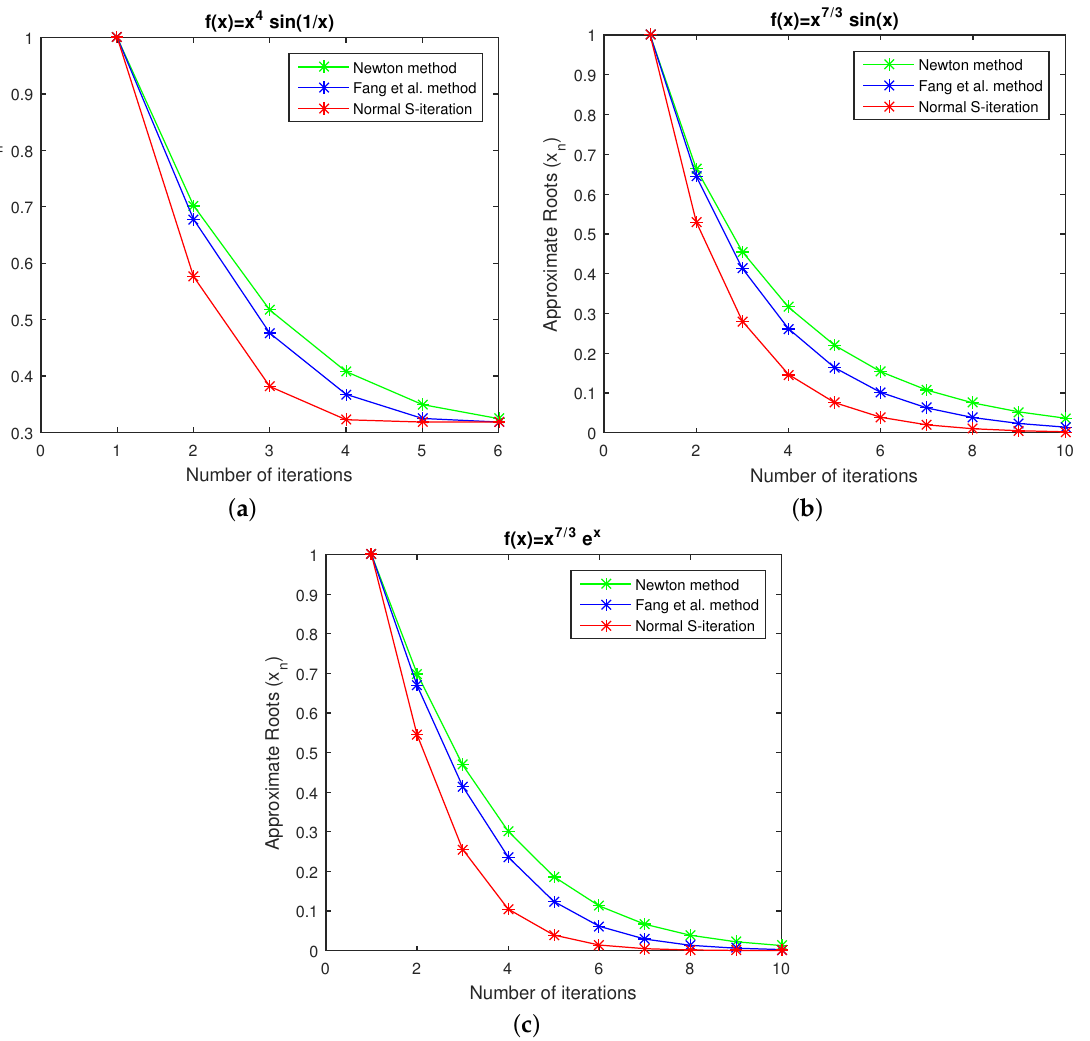
Figure 2. Graph using roots and number of iterations: ( a ) Graph for f 2 ; ( b ) Graph for f 3 ; ( c ) Graph for f 5